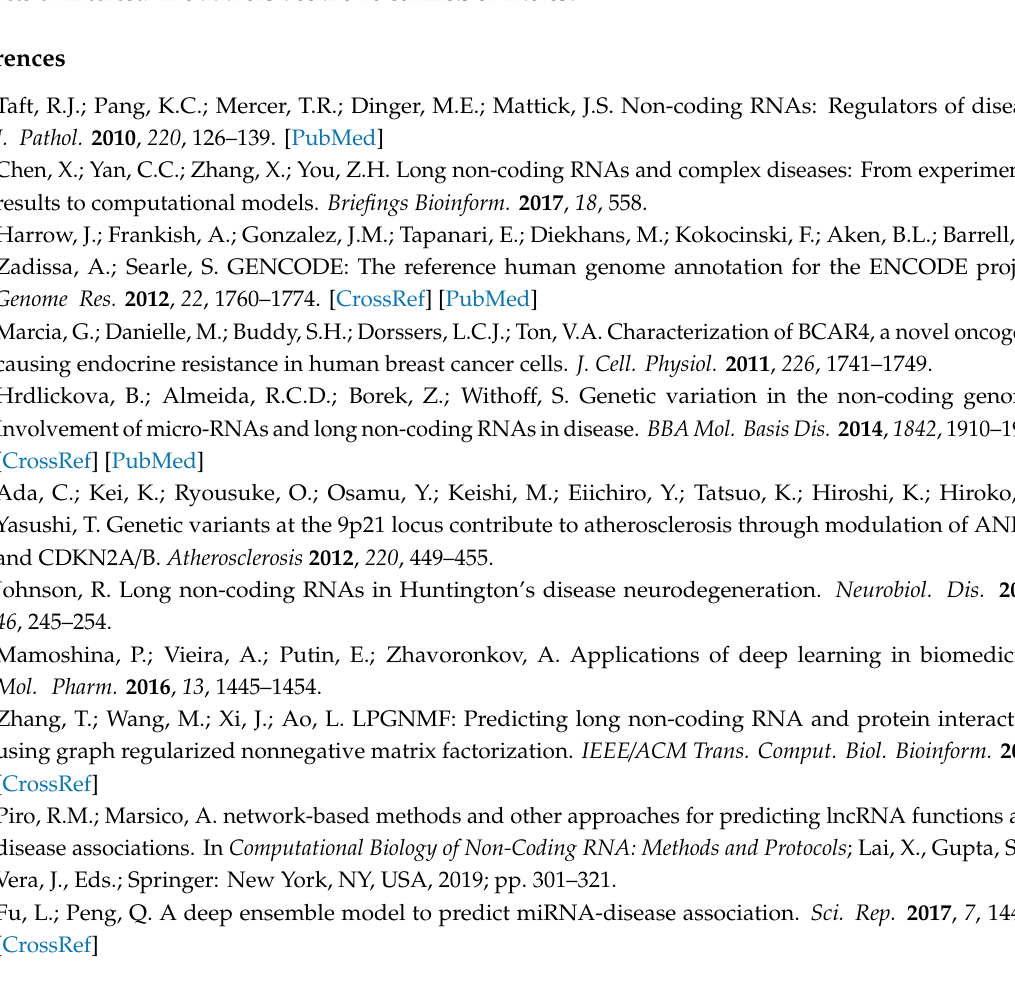
Table S1: AUC and AUPR of GCNLDA in each cross-validation. Table S2: The top 15 potential lncRNA candidates for 405